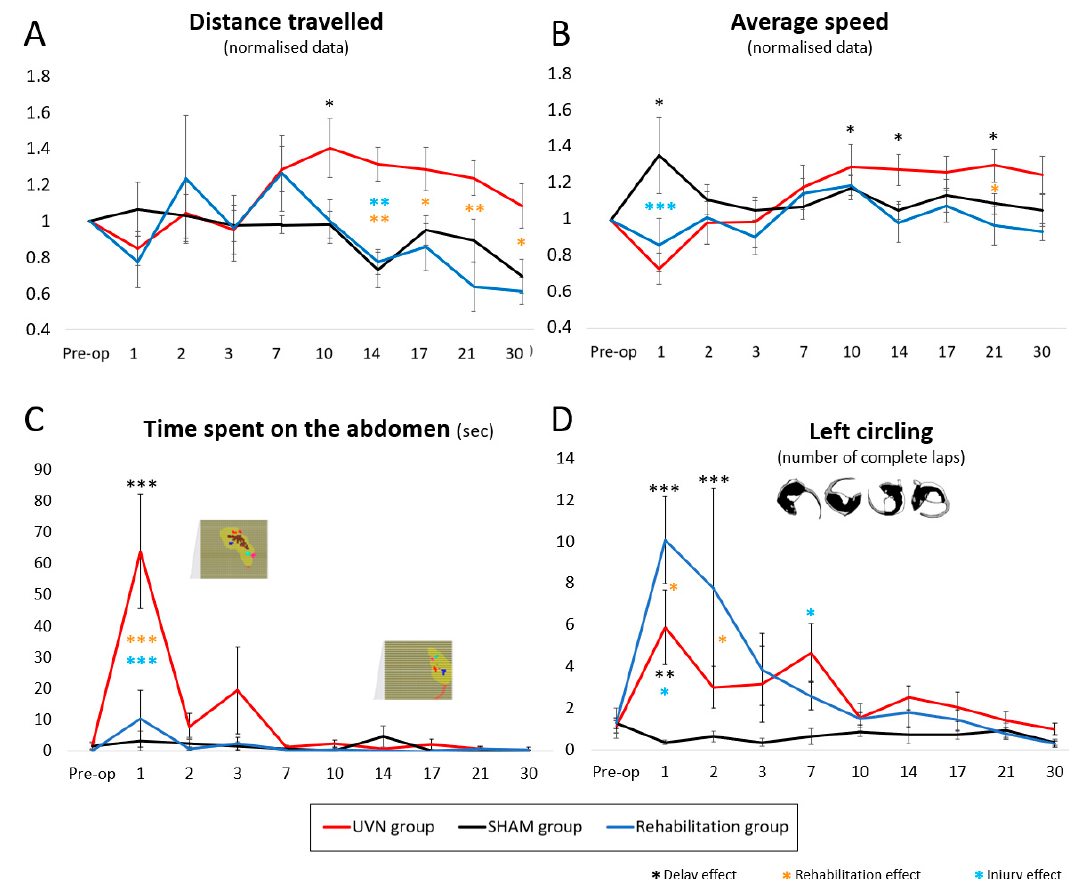
Figure 4. Behavioural activity. This figure summarizes the behavior of the animals when they are in the DWB2. ( A ) Dis- tance travelled. From D10, this parameter increased significantly in the UVN group (delay effect, p < 0.05). From D7